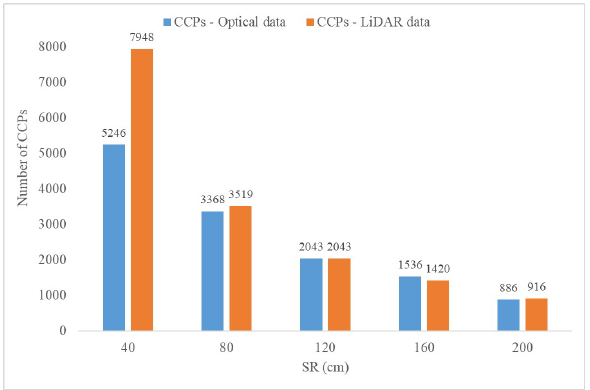
Figure 7. CCPs’ size at different SRs